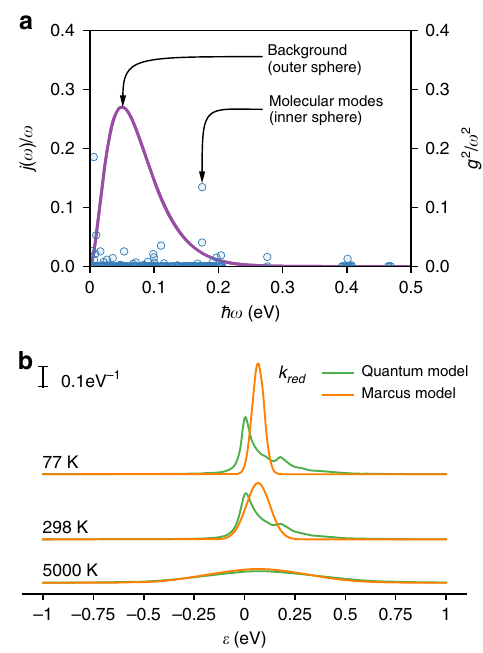
Fig. 4 Comparison of rate constants for quantum and Marcus models. a Spectral density used for the quantum model consisting of a background and individual molecular modes calculated by DFT. Background parameters: λ = 25 meV, ћ ω = 25 meV. b Calculated k red at the drain electrode as a o o function of chemical potential for 3 different temperatures for the quantum and Marcus models. Parameters: quantum: λ o = 25 meV, ћ ω c = 25 meV, λ